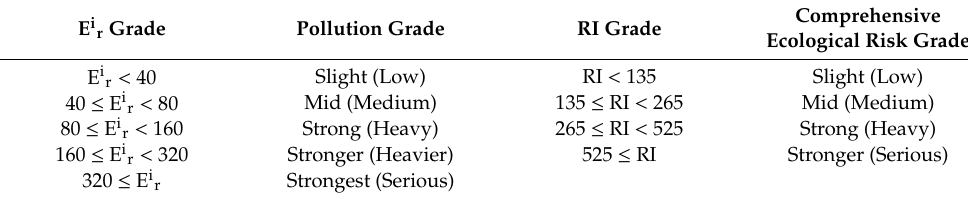
Table 1. Grading standards of potential ecological risk assessment, source: